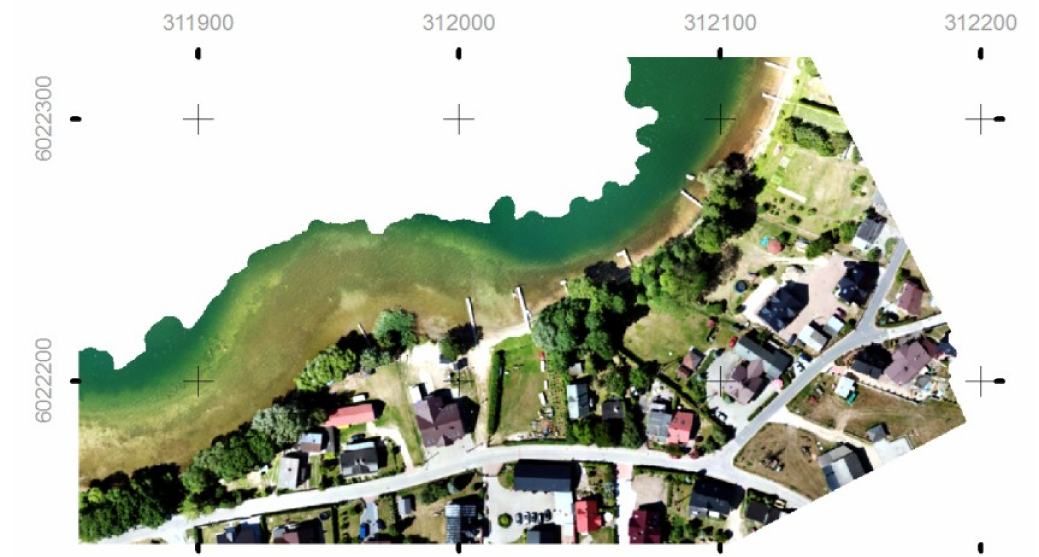
Figure 7. Reconstructed